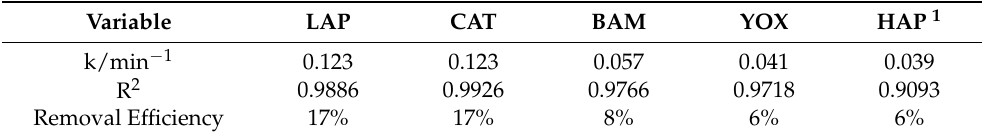
Table 3. Exponential constant, k, and coefficient of determination, R 2 , of the early phase removal with the associated removal efficiency of each